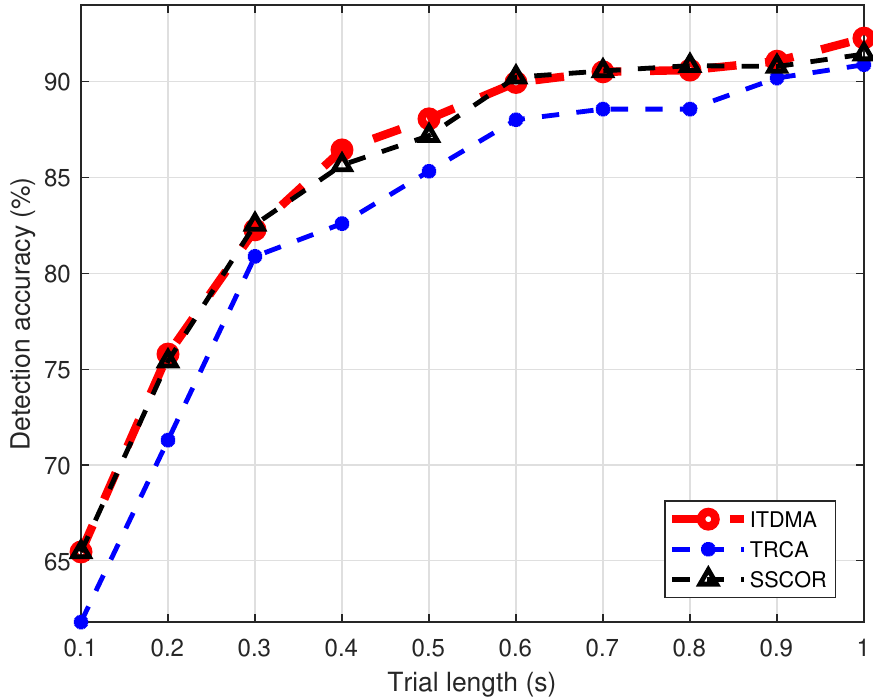
Figure 6. Detection accuracy comparison versus the trial